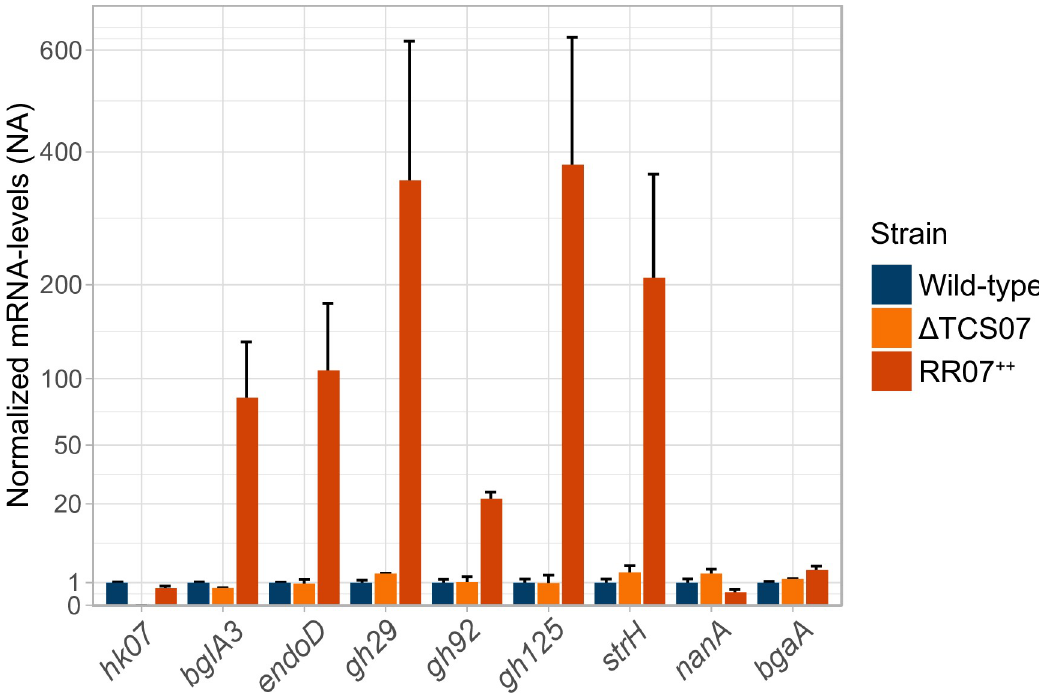
Fig 2. Validation of RNA-seq by RT-qPCR. Validation was performed by repeating the experimental setup for RNA-seq with inclusion of a tcs07 mutant and performing RT-qPCR on the extracted RNA with primer sets for selected upregulated genes and hk07 , nanA and bgaA . mRNA levels were normalized to gyrA and mRNA fold-changes are relative to the wild-type. Performed in biological duplicates with standard deviation as error bars.